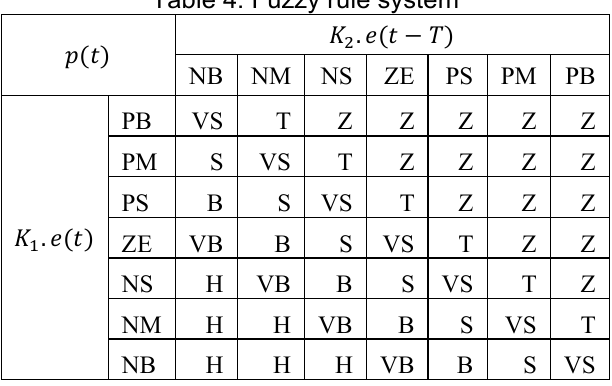
Table 4. Fuzzy rule system